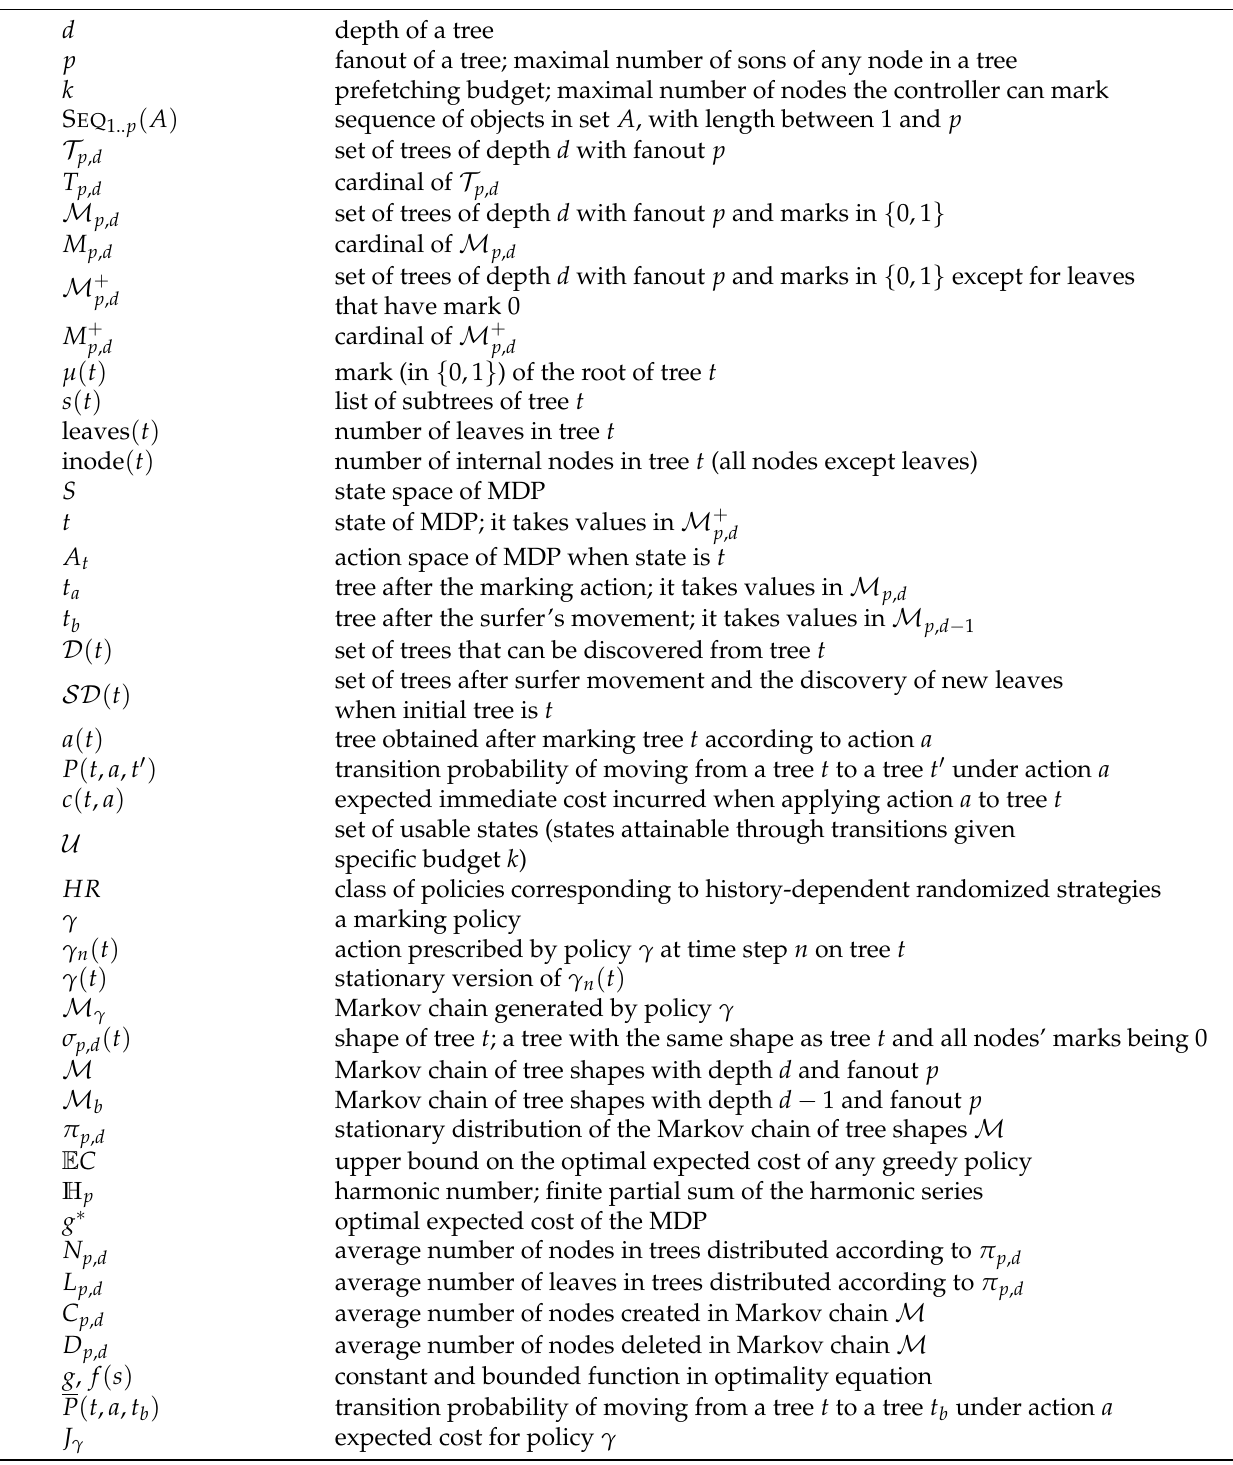
Table A1. Main notation used in the